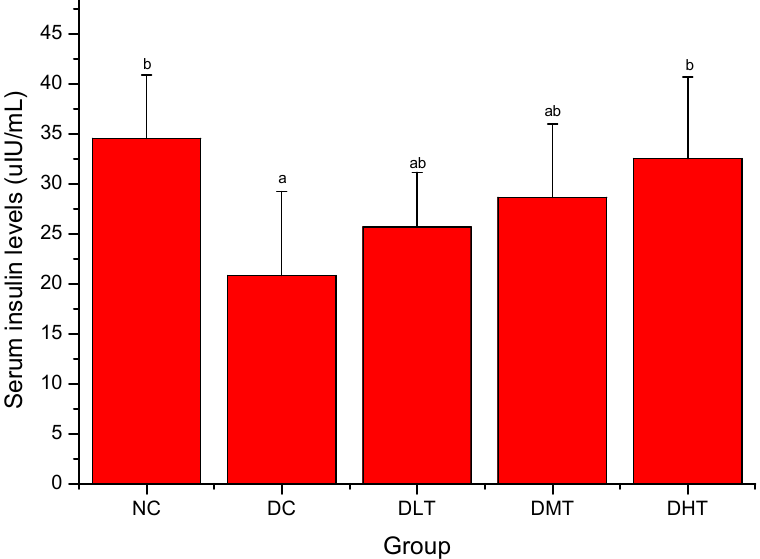
Figure 3. Effect of salidroside administration on serum insulin levels in mice. Data were presented as means ± SD. NC: normal control, DC: diabetic control; DLT: low dose salidroside (50 mg/kg) treatment, DMT: middle dose salidroside (100 mg/kg) treatment, DHT: high dose salidroside (200 mg/kg) treatment. a P < 0.05 as compared with the NC group. b P < 0.05 as compared with the DC